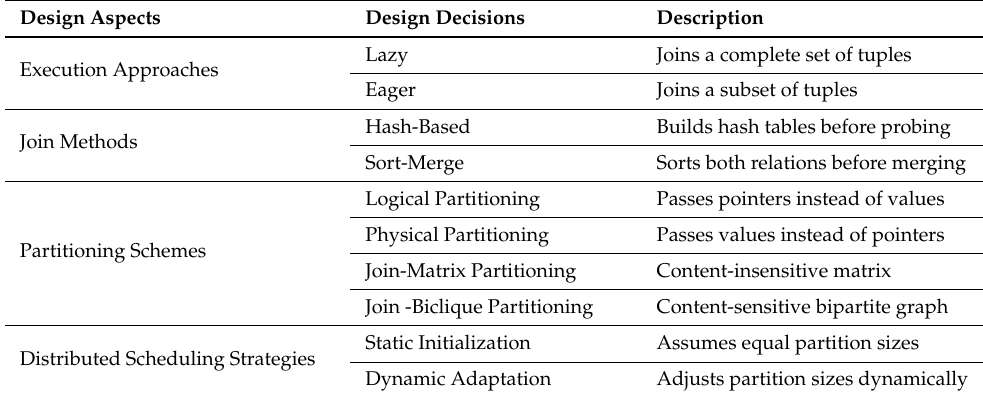
Table 2. Summary of Design